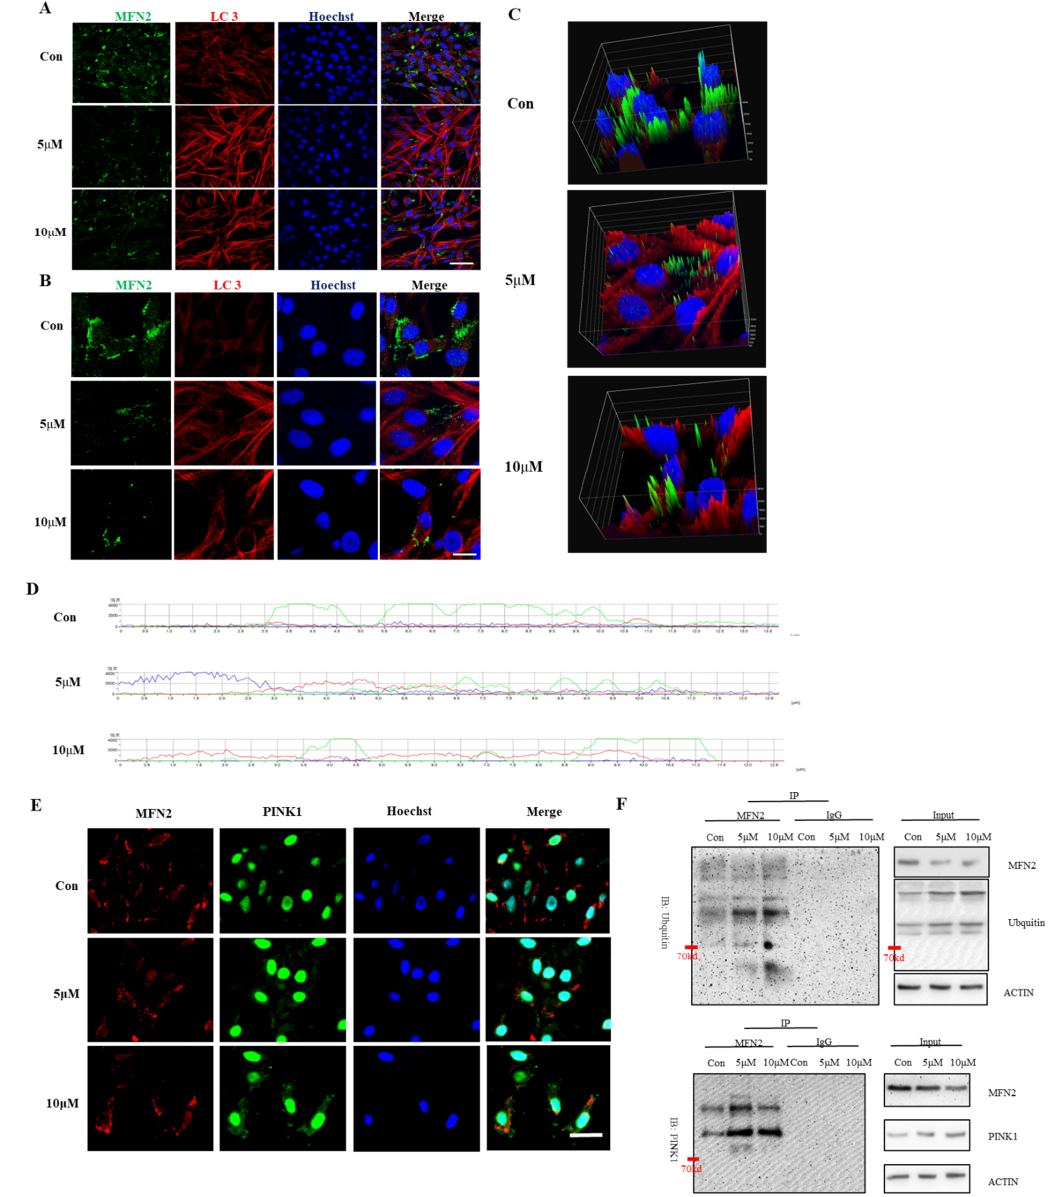
Figure 7. PbAc treatment promoted MFN2 protein undergoing ubiquitination . Western blotting and immunofluorescence were used to detect changes in autophagy degradation and the ubiquitin-pro- teasome pathway. Immunofluorescence was used to detect the co-expression of autophagy-related protein LC3 with mfn2 after Pb exposure for 12 h ( A ) and 24 h ( B ). Three-dimensional reconstruction of PC12 cells exposed to Pb for 24 h was performed using NIS-Elements ( C ), and the fluorescence co-expression of LC3 and Mfn2 proteins was analyzed by NIS-Elements ( D ). Immunofluorescence ( E ) and immunoprecipitation (IP) ( F ) were used to detect the co-expression of ubiquitin E3 ligase PINK1 with mfn2.